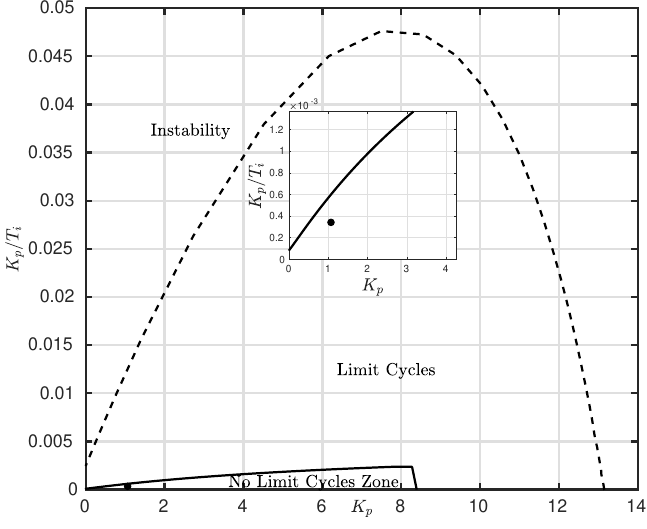
Figure 3. Stability region for daytime controller.